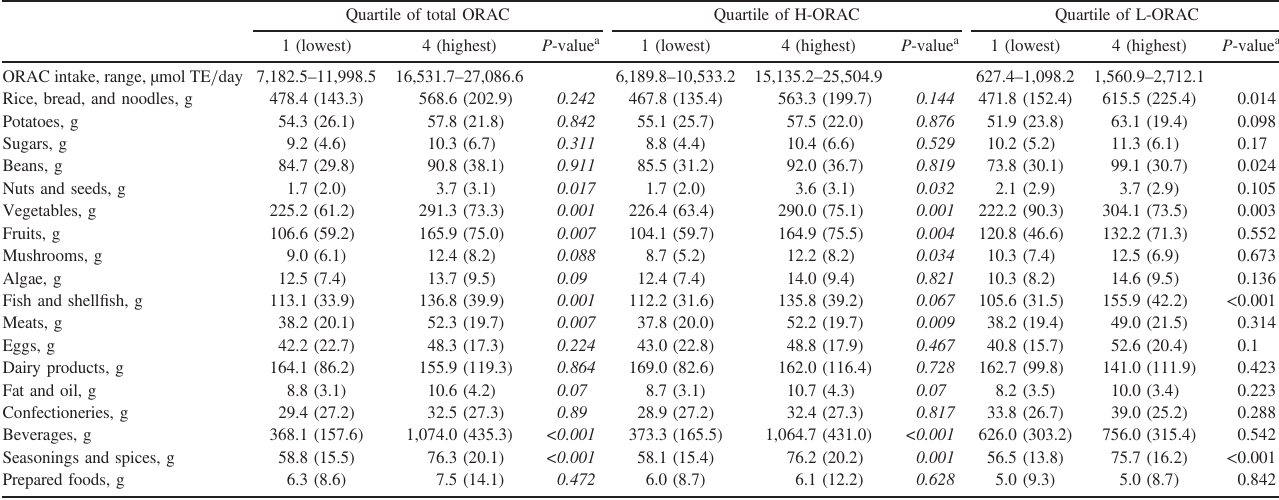
Table 4. The distribution of dietary characteristics across quartiles for AOC in the study participants Quartile of total ORAC Quartile of H-ORAC Quartile of